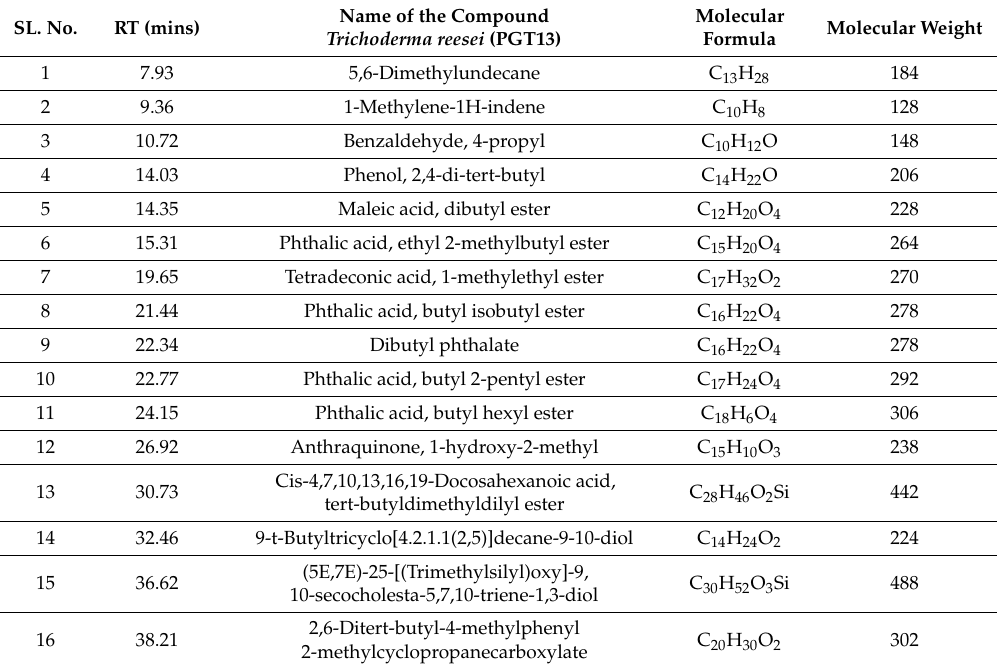
Table 4. List of compounds of Trichoderma reesei (PGT13) detected by GC-MS. RT—Retention Time. SL.